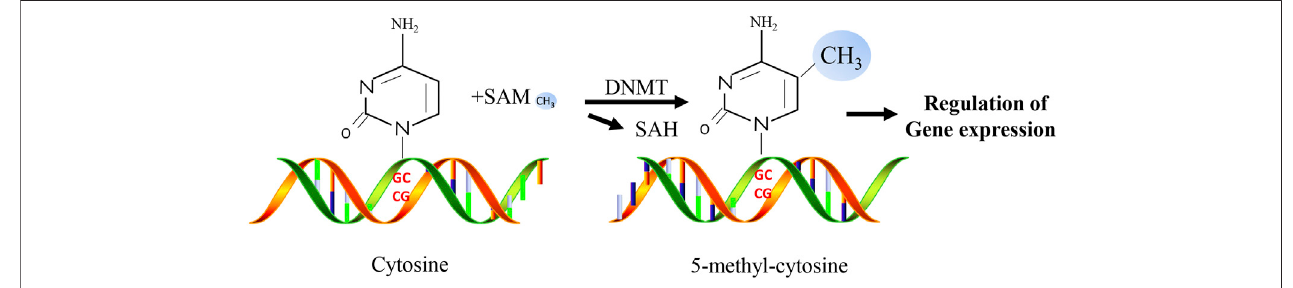
FIGURE 2 | Simpli fi ed overview of molecular mechanisms of DNA